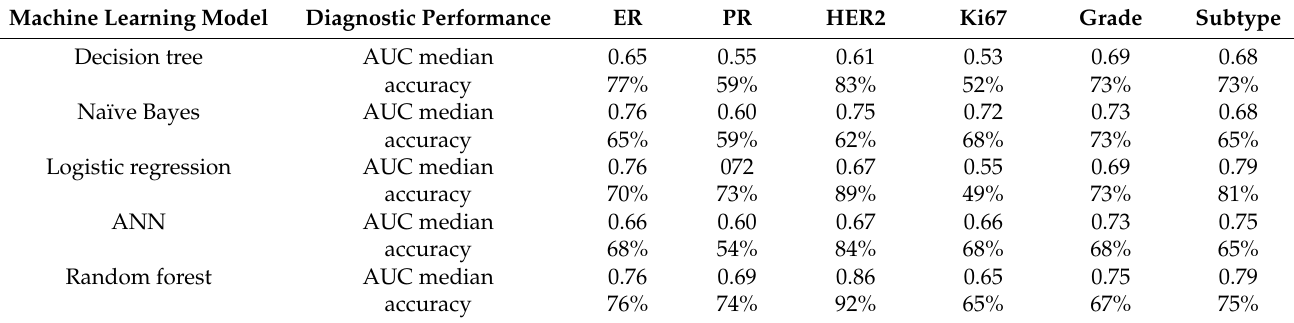
Table 5. AUCs and accuracies of integrated machine learning models using perfusion and texture features to predict each histological